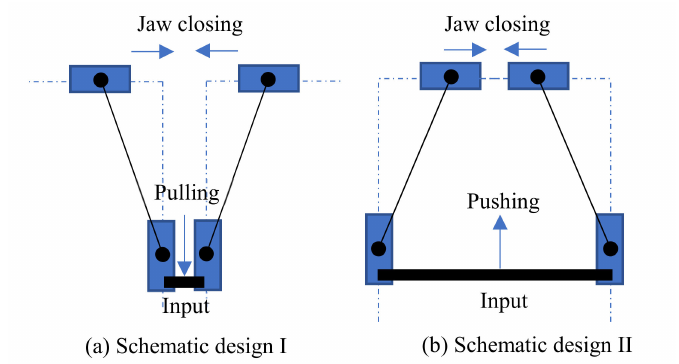
Figure 1. Two schematic design using double-slider compliant